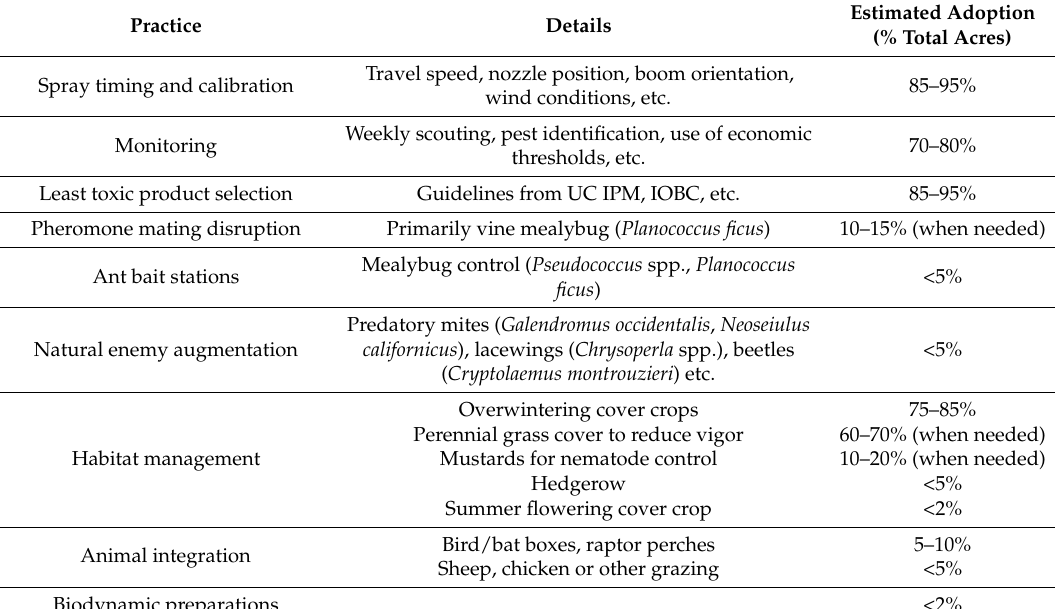
Estimated adoption rate (as % of total acres) of integrated pest